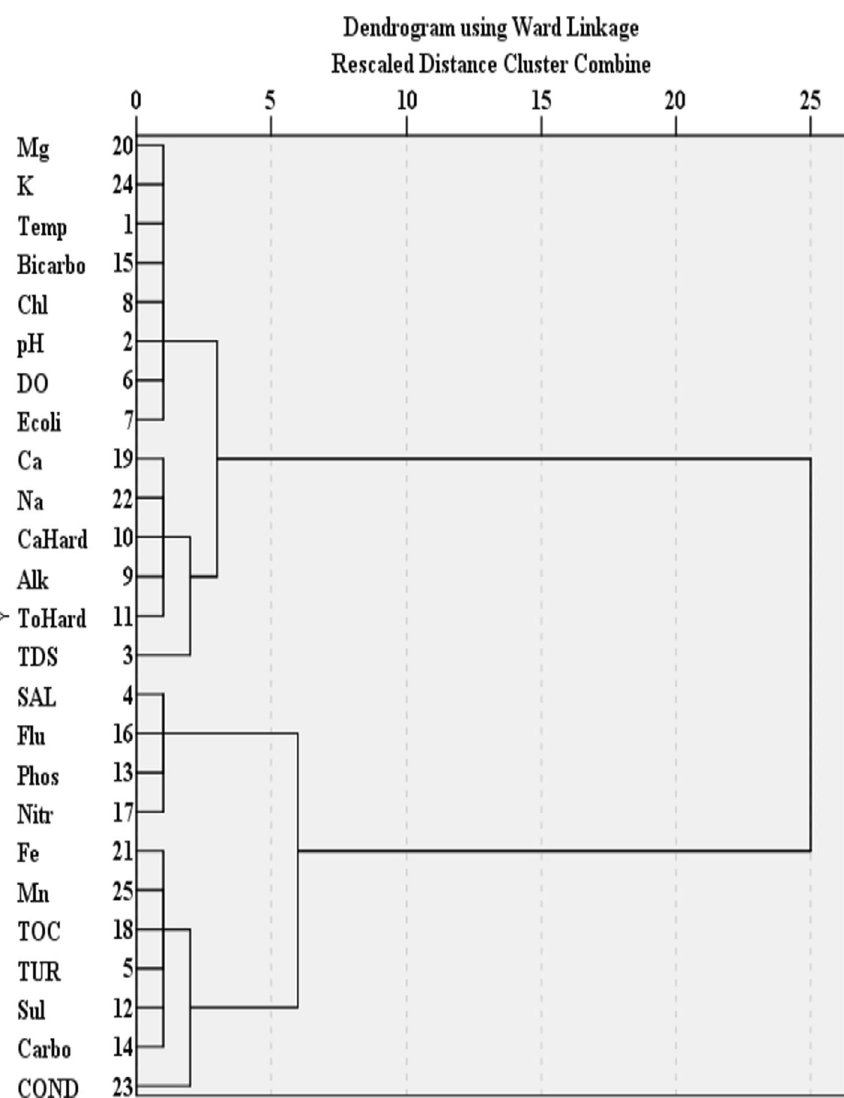
Fig. 4 Dendrogram of the Q-mode cluster analysis of winter season. (The axis shown below indicates the relative similarity of different cluster groups. The lesser the distance, the greater the similarity between